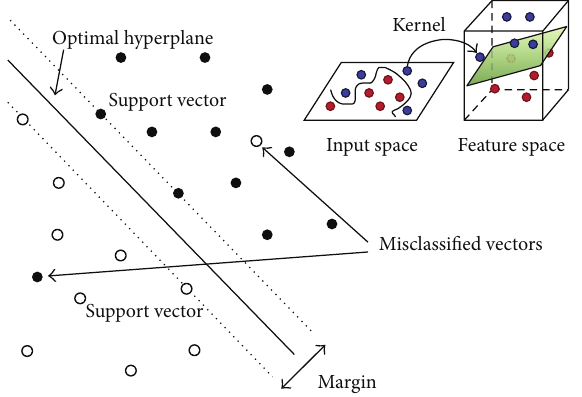
Figure 4: Principle of support vector